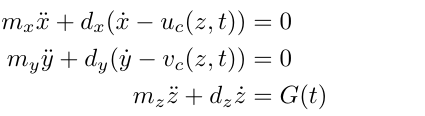
Figure 2: Schematic of a NEMO float (courtesy of